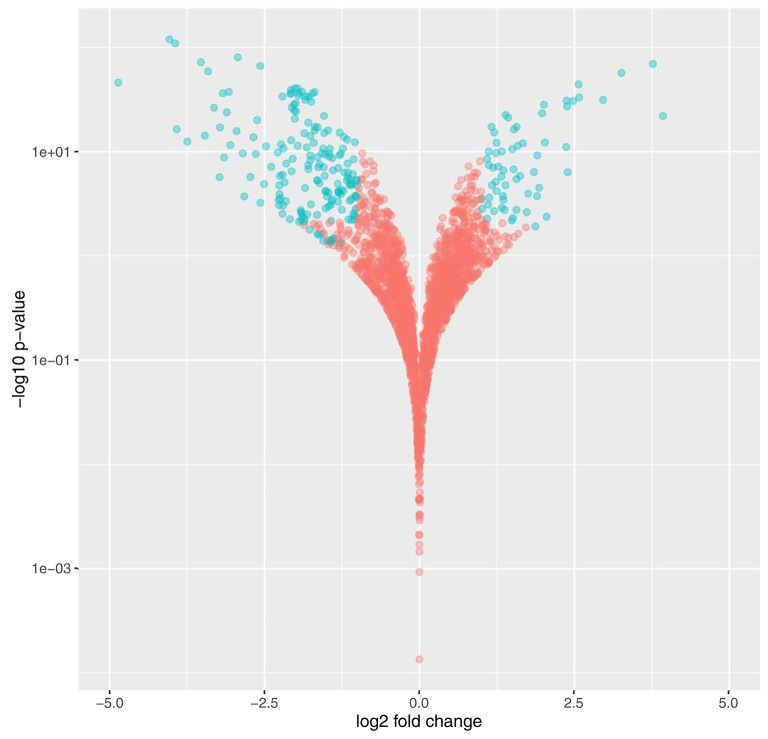
Volcano plot demonstrating significant changes to the Synechococcus sp. BL107 transcriptome post SWiFT filtration. Genes demonstrating < 0.05 q-value and >2-fold change in gene expression are highlighted in blue.